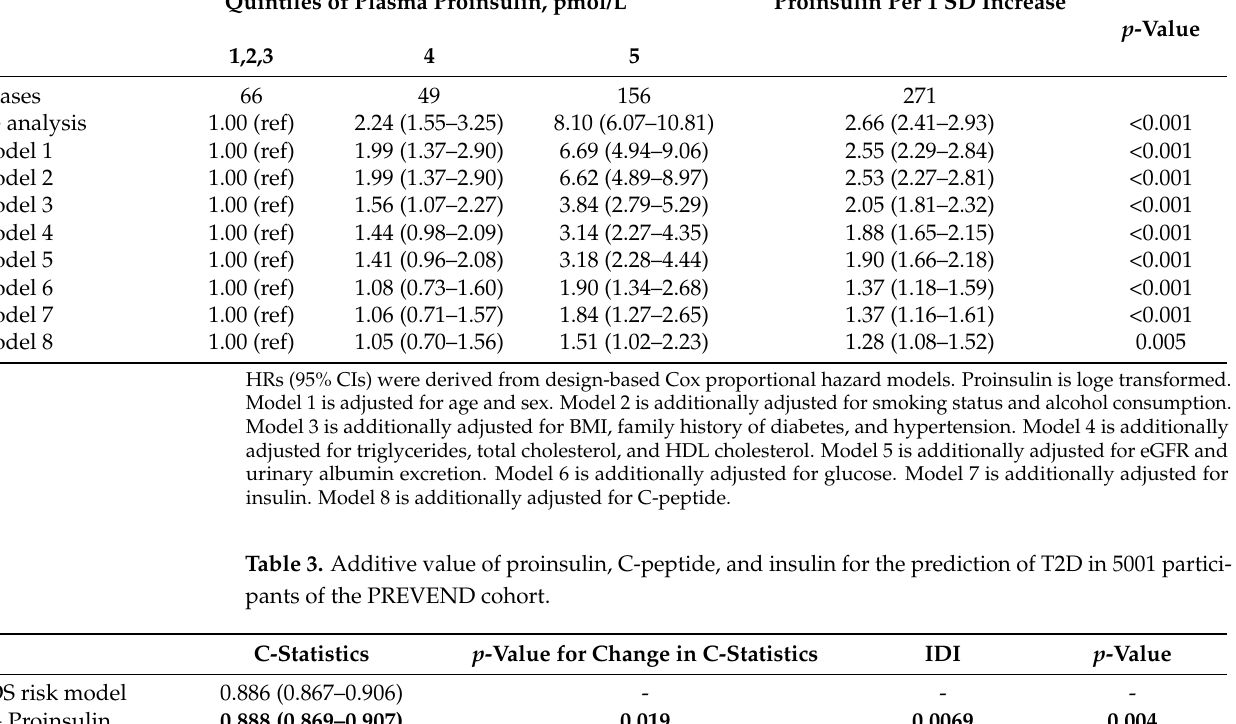
Figure 1. Kaplan–Meier curves for diabetes survival according to quintiles of proinsulin in 5001 participants of the PREVEND study. PREVEND: Prevention of Renal and Vascular End-Stage Disease. Table 2. Association between proinsulin and risk of incident type 2 diabetes (T2D) in 5001 participants of the PREVEND study.